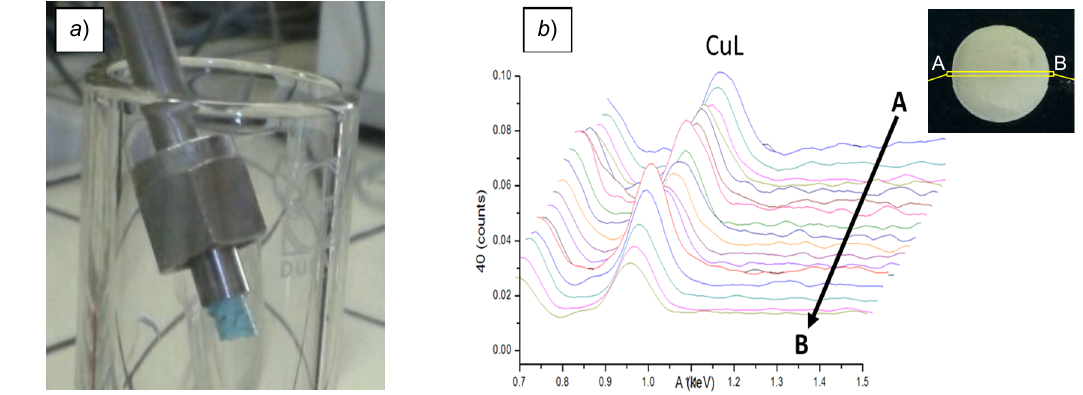
Figure 2. Appearance of the M7 ∙ Cu(OTf) 2 monolith ( a ) and relative intensity of the L α , β Cu lines, collected by SEM-EDS analysis along the scanning path A-B shown in the inset ( b ).